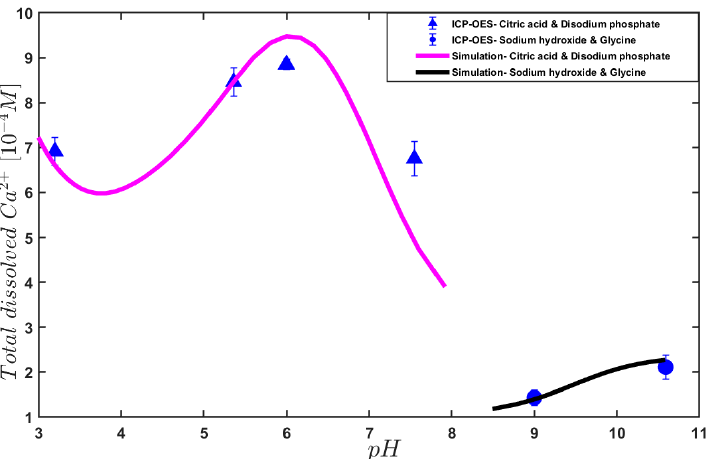
Figure 5. Total dissolved COM expressed as the total dissolved Calcium concentration in the solution citric acid-disodium phosphate buffer with a pH of 3.2, 5.36, 6.0, 7.55 (blue triangles) and glycine-sodium hydroxide buffer with a pH of 9.0, 10.6 (blue dots) at 37 °C. In addition, the simulated total dissolved Ca concentration as function of pH in a citric acid-disodium phosphate buffer (magenta line) and in a glycine-sodium hydroxide buffer (black line) is given.